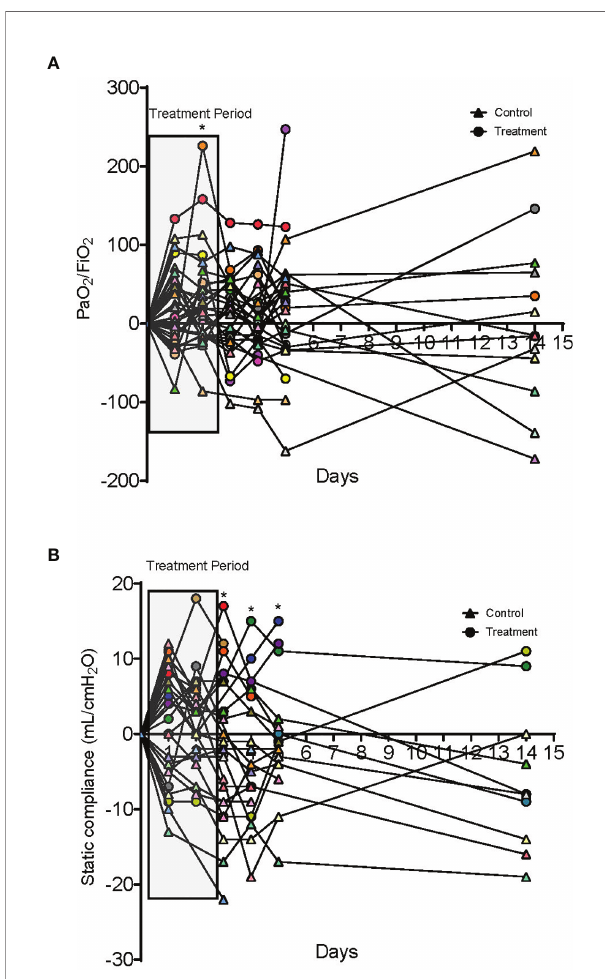
FIGURE 2 | Oxygenation and compliance responses to dornase alfa treatment. (A) Change in PaO 2 /FiO 2 compared to day 0. Each colored circle symbol represents a unique patient in the treatment group and each colored triangle symbol represents a unique patient in the control group. A signi fi cant increase is noted in the treatment group at day 2 of treatment with a non- statistically signi fi cant increase for the additional 14 days. (B) Change in static lung compliance (mL/cmH 2 O) compared to day 0. Each colored circle symbol represents a unique patient in the treatment group and each colored triangle symbol represents a unique patient in the control group. Starting on day 3 there was a signi fi cant improvement in lung compliance in the treatment group compared to the case control group that was sustained to day 5. No statistically signi fi cant difference was noted at 14 days.